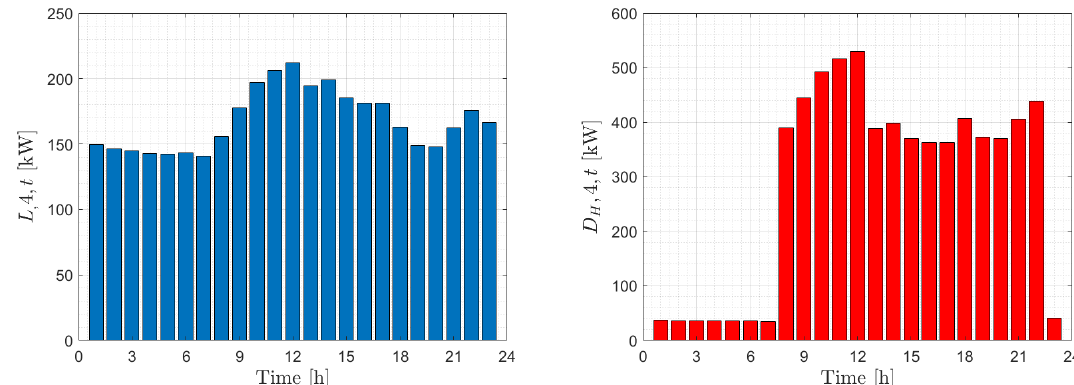
Figure 5. Electrical demand of the LU number 2 (Building).